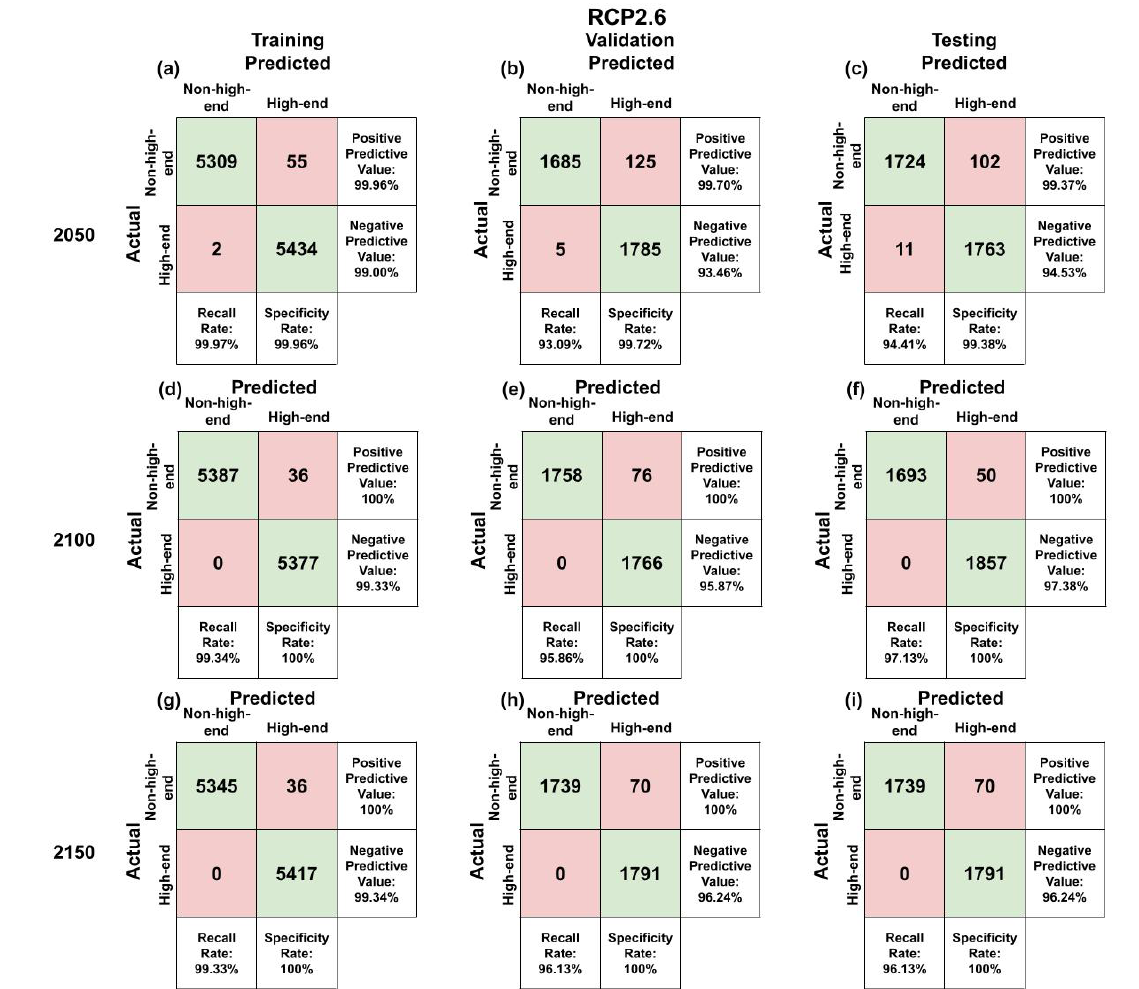
Figure A2. Random forests’ confusion matrices on the RCP2.6 training, validation, and testing